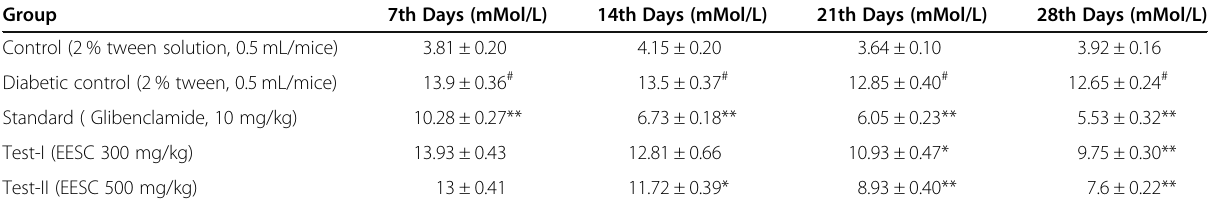
Values are expressed as mean±standard error of mean ( n =6) EESC Ethanolic extract of S. caseolaris (L.) Engl #indicates p <0.0001 compare with control *indicates p ˂ 0.05 compare with STZ control **indicates p ˂ 0.0001 compare with STZ